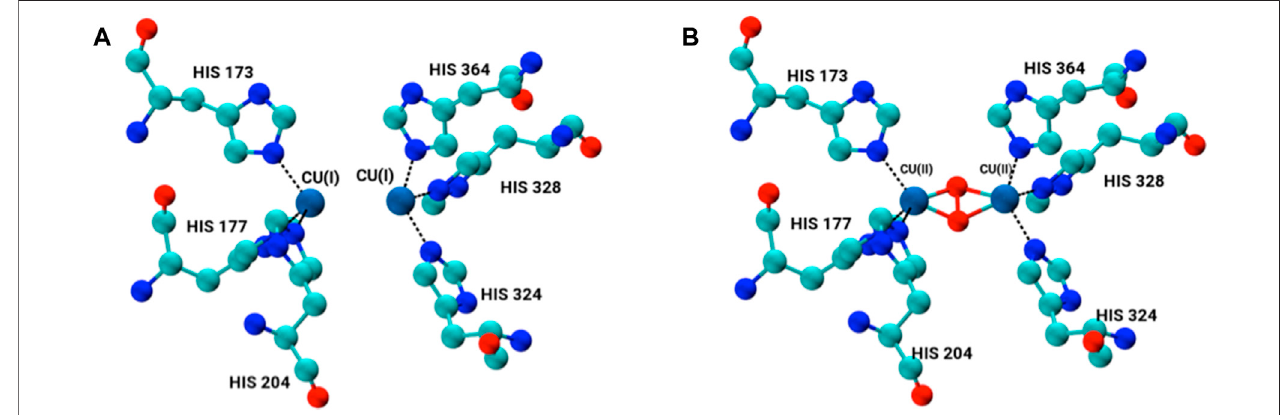
FIGURE 2 | Binuclear copper-containing metal binding site in (A) deoxygenated form and (B) oxygenated form of each monomer subunit within the